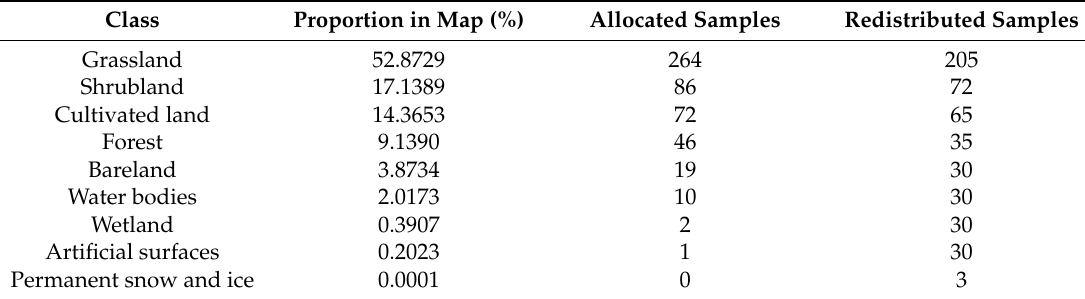
Table 2. Distribution and reallocation of samples across GlobeLand30 classes present in Kenya, sorted according to the proportion of each class in the map in descending order by